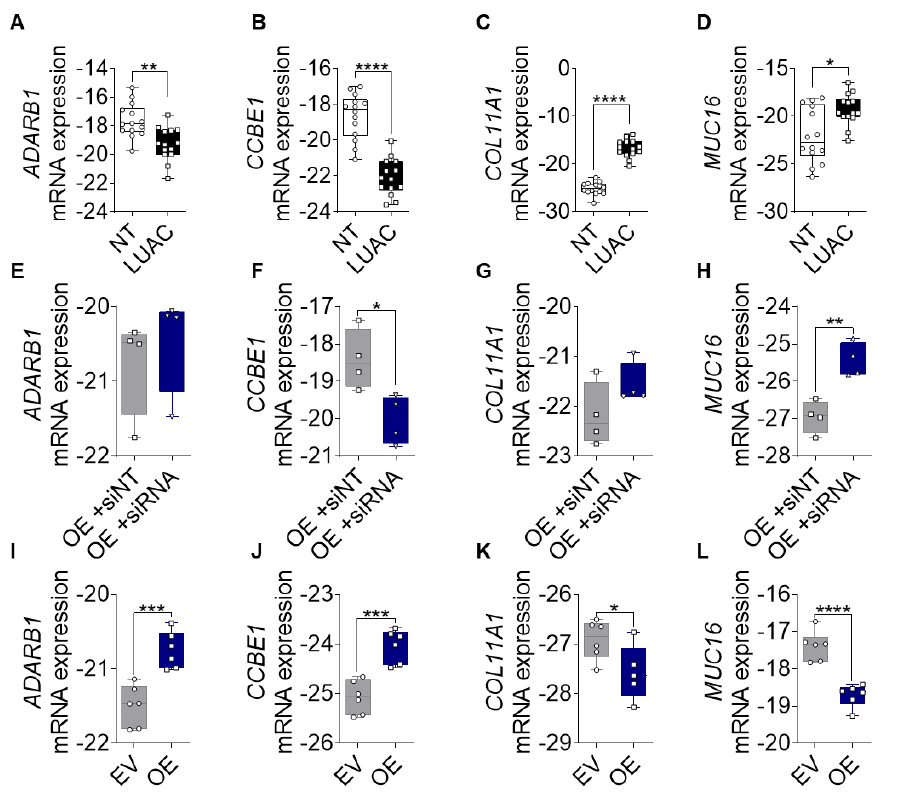
Figure 6. Validation of FGF14 target genes. ( A – D ) mRNA expression of ADARB1, CCBE1, COL11A1 , and MUC16 in human LUAC tissue compared with samples from non-tumor tissue ( n = 14). ( E – H ) mRNA expression silencing of FGF14 in A549-FGF14 OE cells and non-targeting siRNA control samples ( n = 4). ( I – L ) mRNA expression of FGF14 target genes in FGF14 OE and FGF14 EV tumor tissues from immunodeficient xenograft model ( n = 6). Data are presented as mean ± standard error of the mean using Student’s t -test. P- values ≤ 0.05 were considered statistically significant for all analyses. * p ≤ 0.05, ** p ≤ 0.01, *** p ≤ 0.001, and **** p ≤ 0.0001.